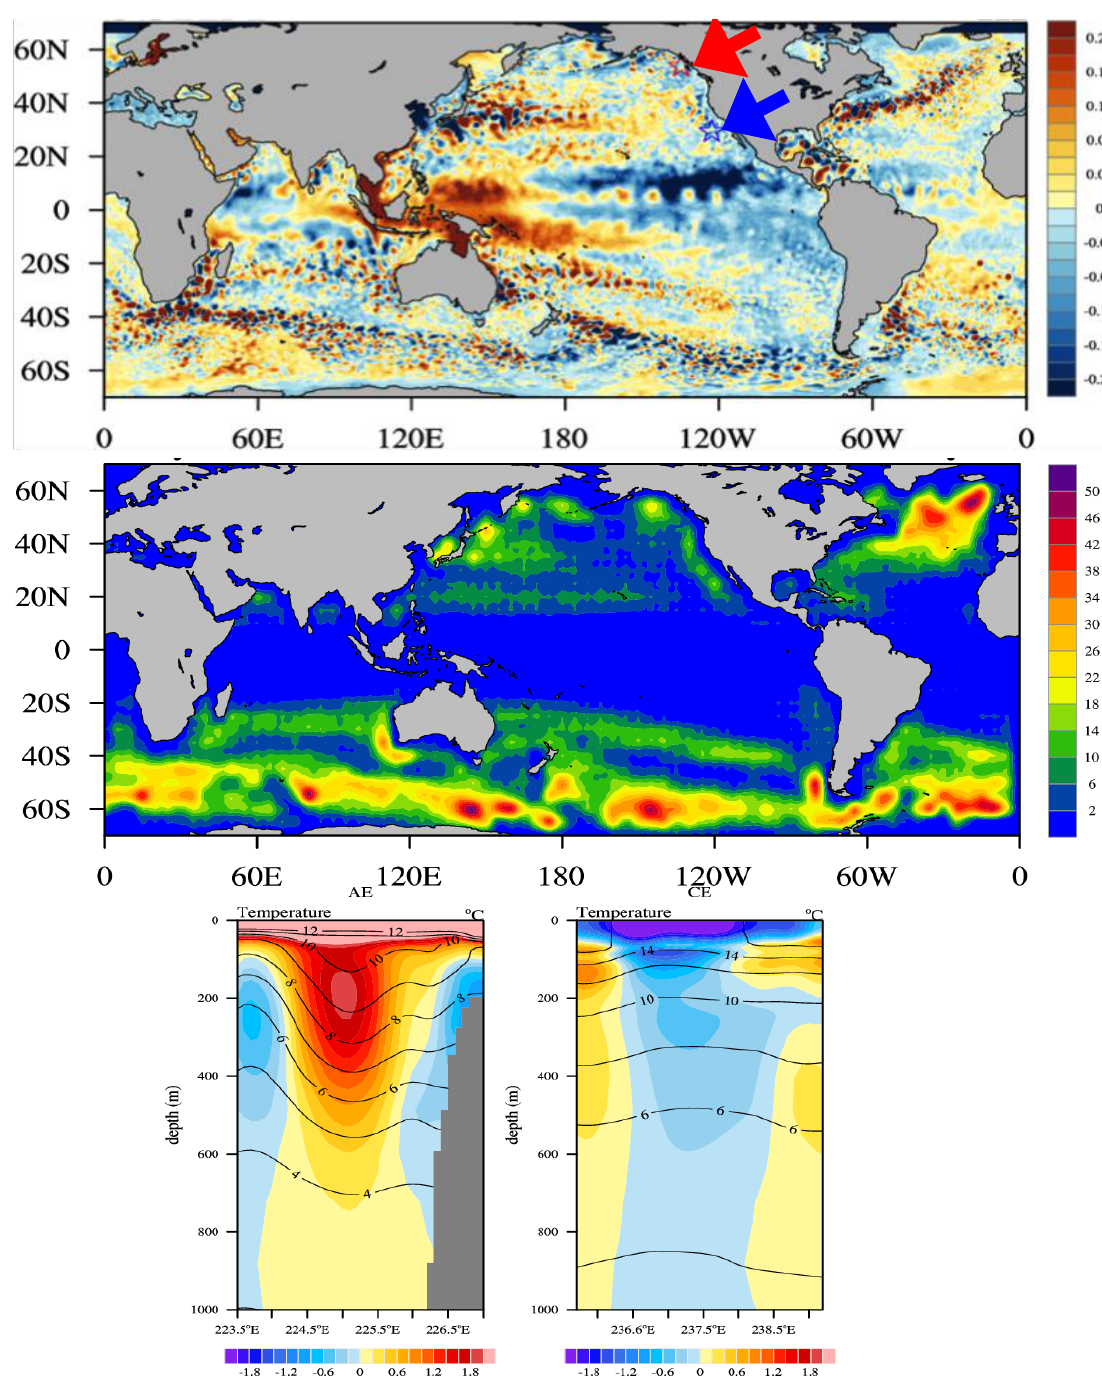
Figure 12. Output of the LICOM